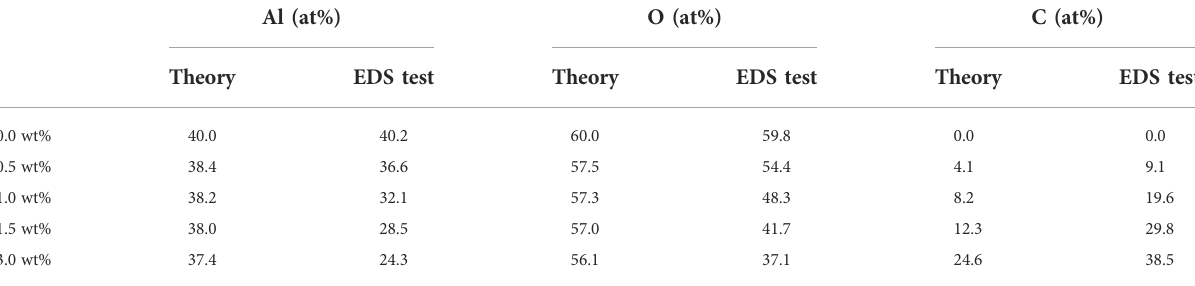
TABLE 1 Contents of Al, O and C in Al 2 O 3 -G composites with different graphene contents. Al (at%) O (at%) C (at%) Theory EDS test Theory EDS test Theory EDS